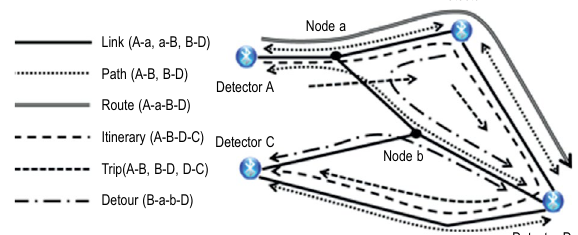
Fig. 4. Definitions (link, path, route, itinerary, trip and